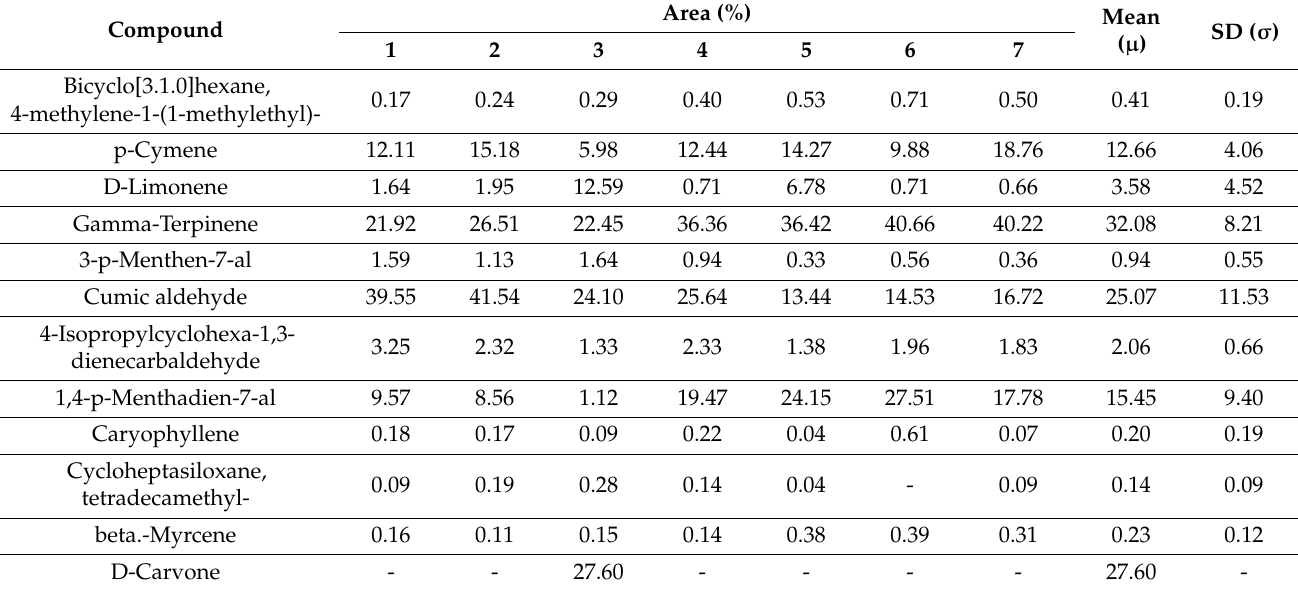
Table 1. Essential oil composition in different accessions of B. persicum collected from different climates of Northwestern